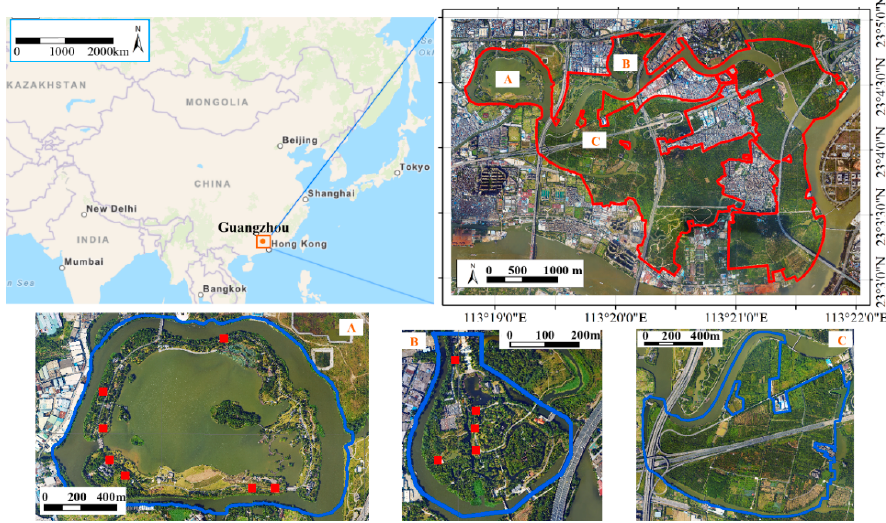
Figure 1. The location of Haizhu Wetland and three separate parts with true-color composites in the Haizhu Wetland were selected as the study area. Area A is also referred to as Haizhu Lake Park, and a forest (dominant by broadleaved trees) grows along the lake. Area B is a semiconstructed wetland mixed with various broadleaved trees, including flowering and fruit trees. Area C is mainly covered by neatly arranged fruit trees. The red squares in Areas A and B denote the locations of the field-surveyed plots.